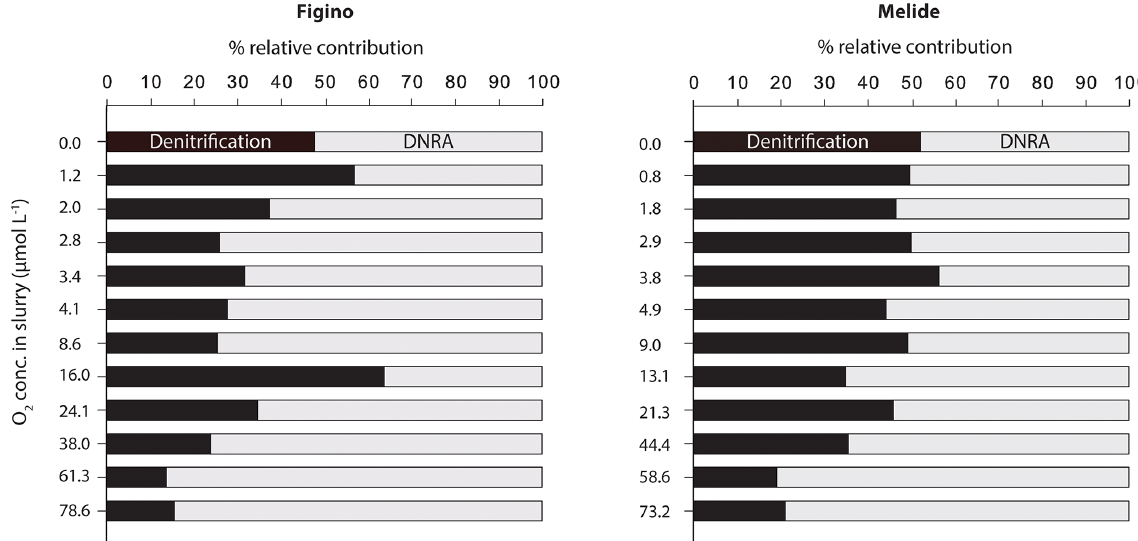
Figure 4. Relative contribution (%) of denitrification and DNRA to total nitrate reduction under variable O 2 conditions.